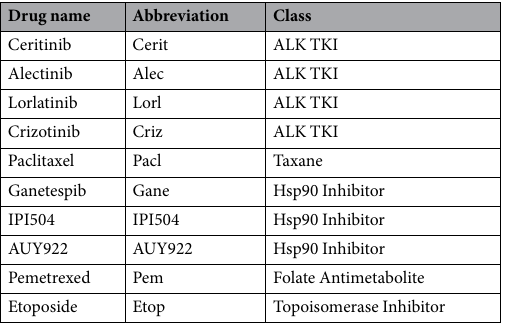
Table 1. Panel of drugs used in study, their abbreviations, and